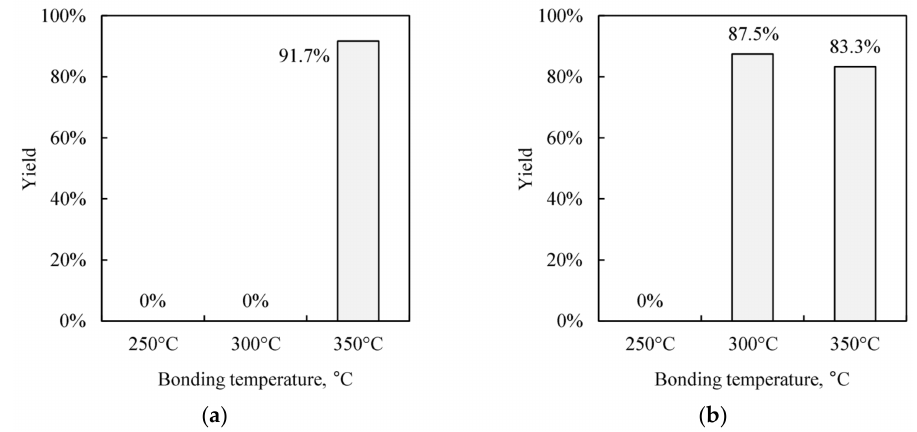
Figure 5. Yields of the hermetic sealed cavities. A pair of bonding wafers is exposed to the atmosphere for 1 h after each pre-treatment. ( a ) Citric acid treated wafer. ( b ) Atomic hydrogen treated wafer.